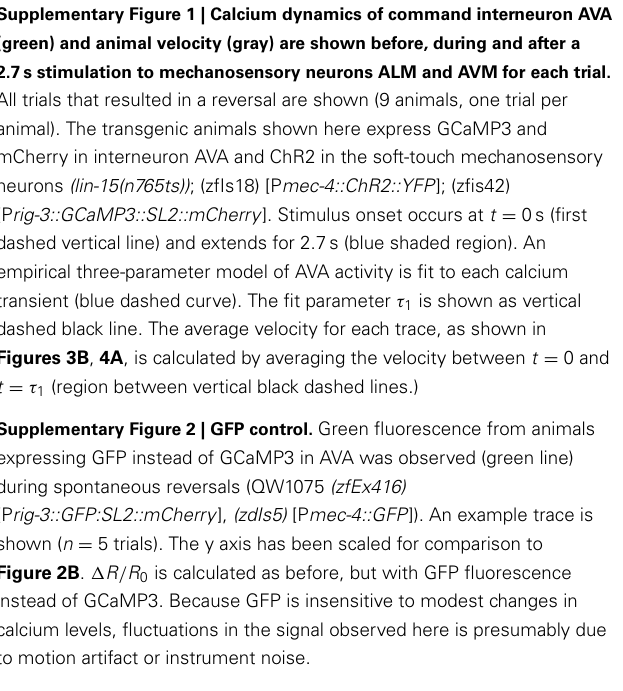
(green) and animal velocity (gray) are shown before, during and after a